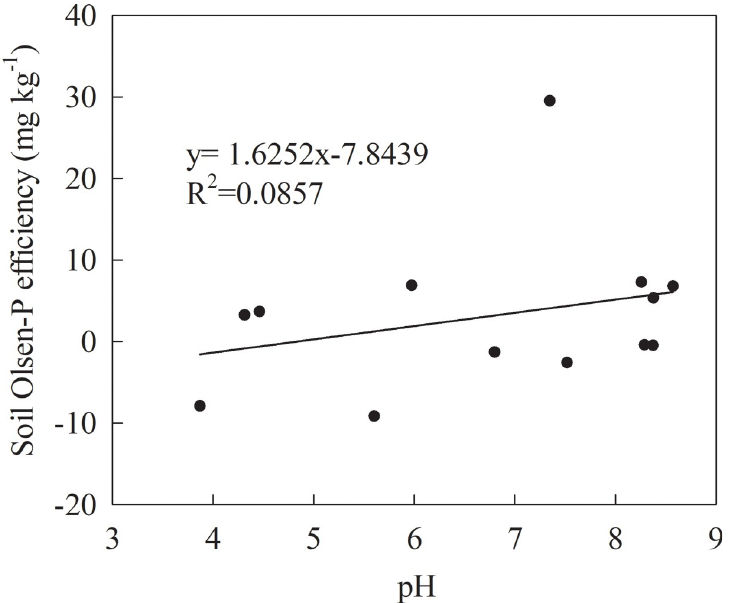
Fig 9. The relation between soil pH and soil Olsen-P efficiency of the three